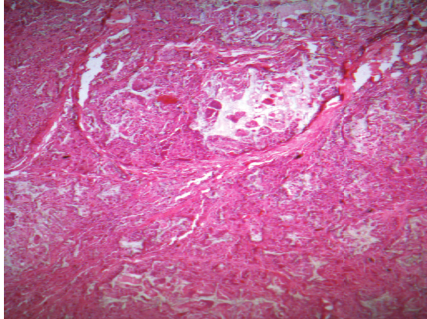
Figure 3: Histologically morphological observations of the exten- sion area in medium item. The extension area was filled with dense fibrous connective tissue and no osteogenesis can be